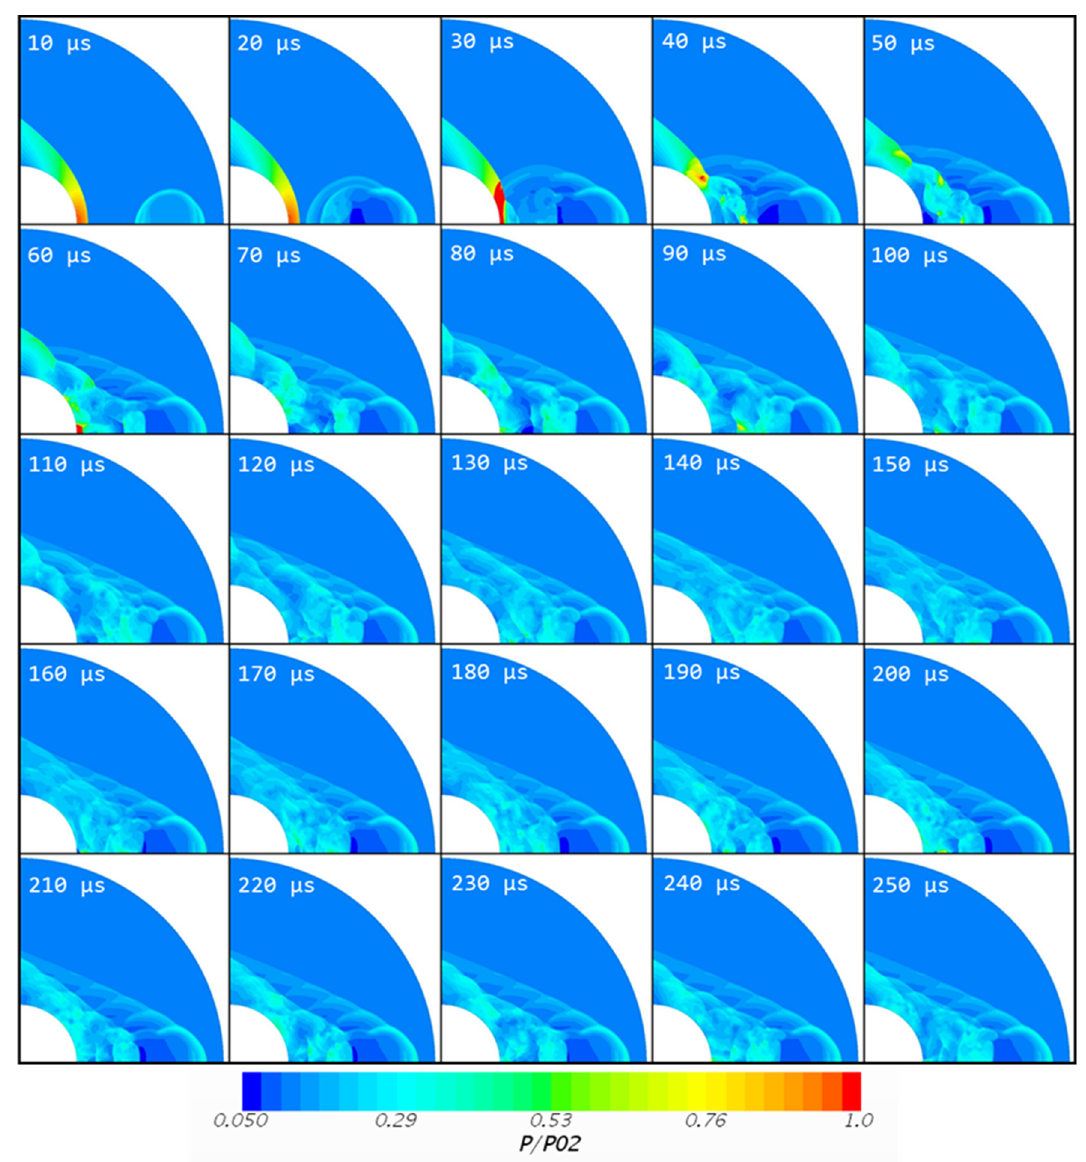
Figure 6. Normalized pressure contours vs. time for deposition frequency of 100 kHz.